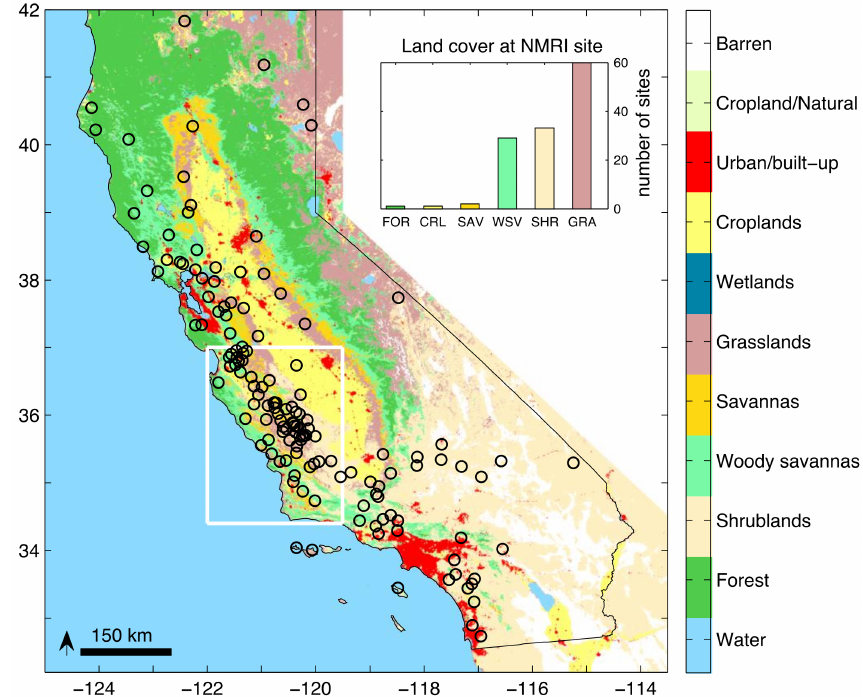
Figure 1. Location of the 146 GPS stations used in this study. The background represents the MODIS IGBP land cover classification. The white rectangle is the region chosen for the regional-average analysis. The inset shows the number of Normalized Microwave Reflection Index (NMRI) sites by land cover type (GRA grassland, SHR shrubland, WSV woody savanna, SAV savanna, CRP cropland, FOR